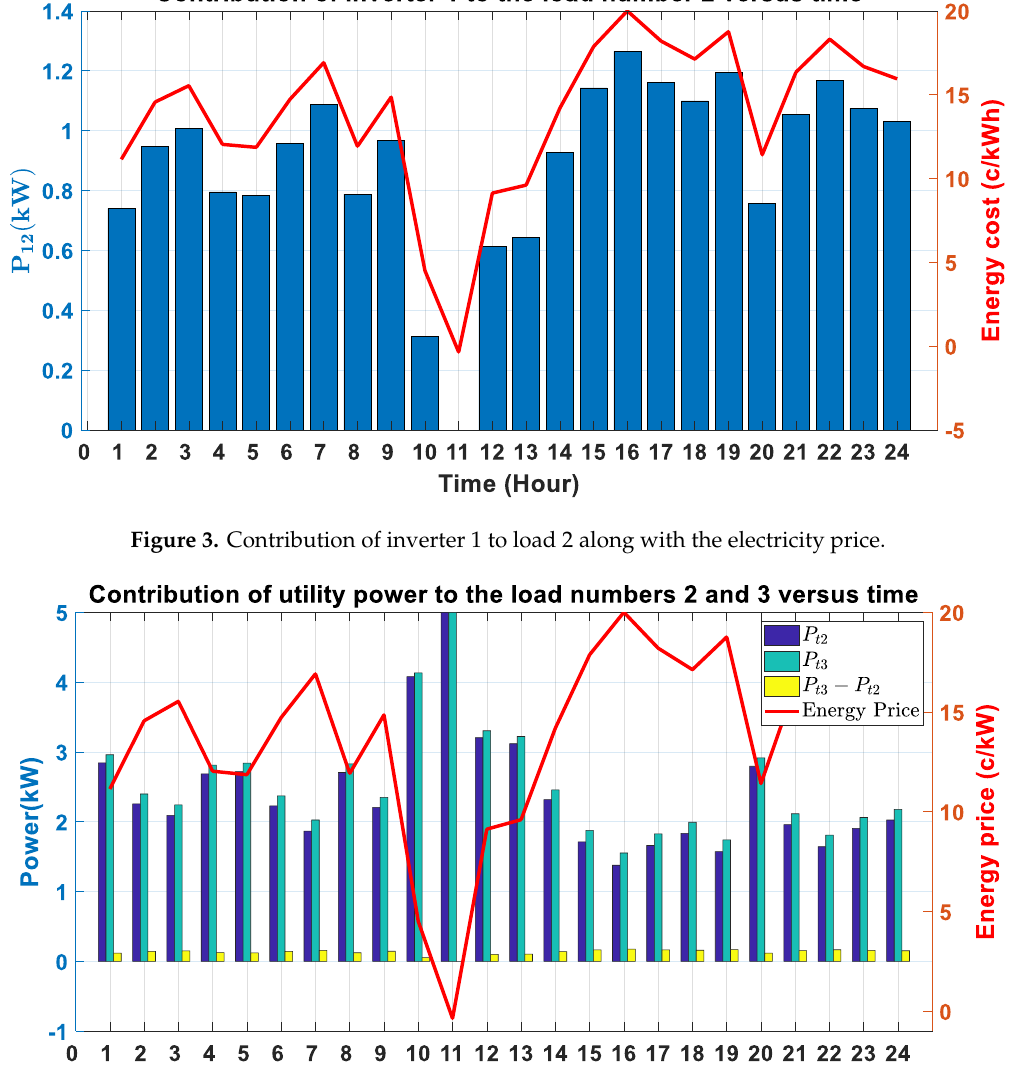
Figure 2. Contribution of inverter 0 to load 2 along with the electricity price.